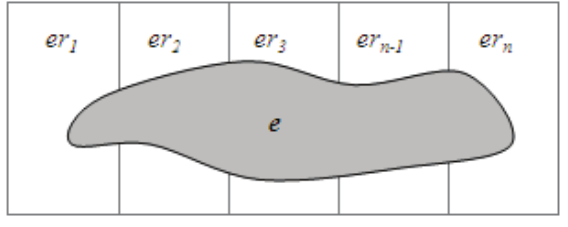
Fig. 2. A sample space and event space of events er and